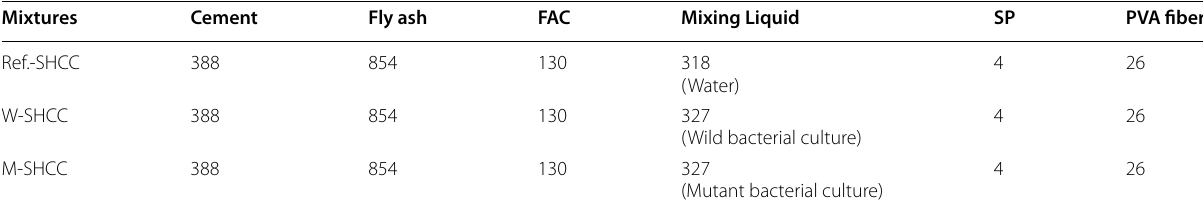
Table 1 Mix proportion of SHCC mixtures (g/L)